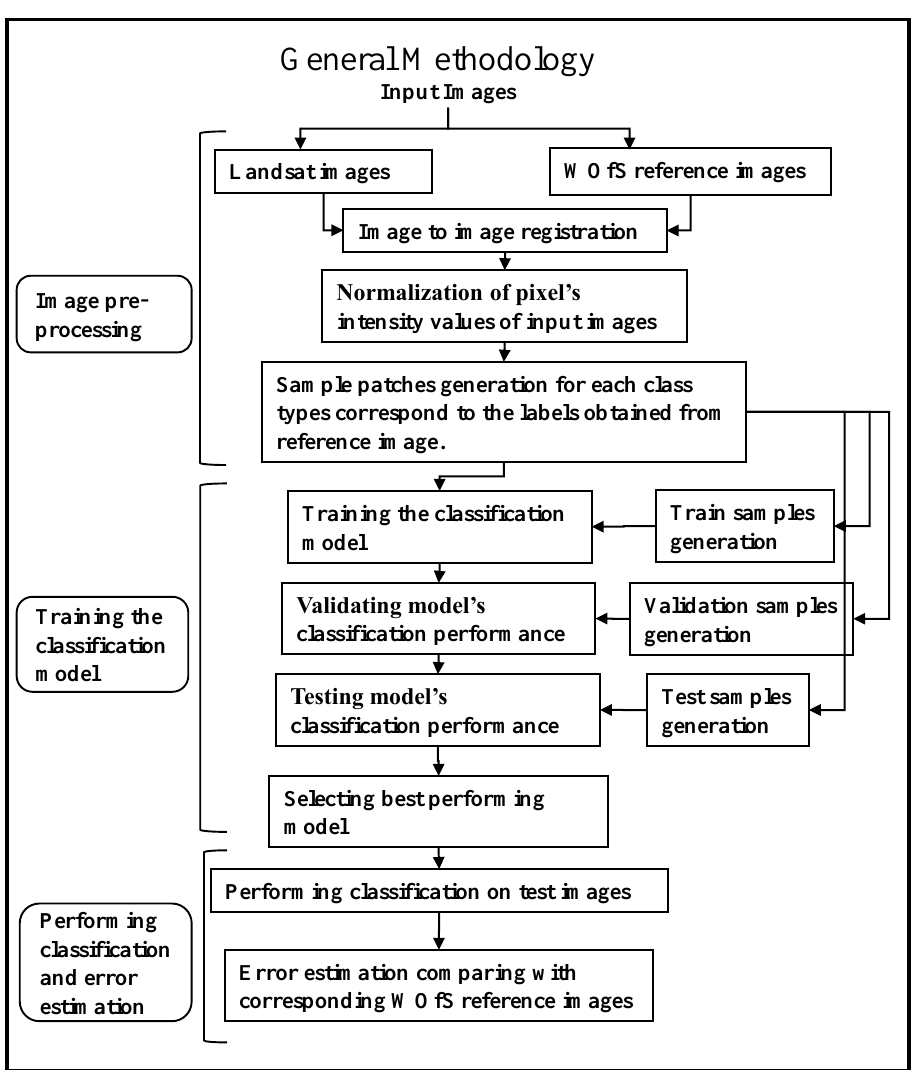
Figure 1. An overview of the stages of our proposed method of flood